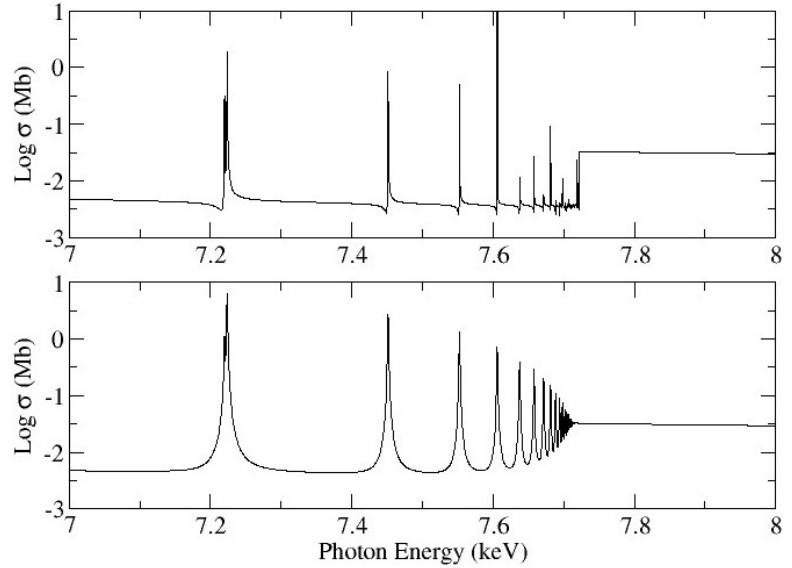
Figure 5. Photoabsorption cross-section of the 1s 2 2s 2 2p 6 1 S ground state of Ne-like Fe XVII in the K-edge region. Top panel : undamped cross-section. Bottom panel : damped (radiation and Auger)